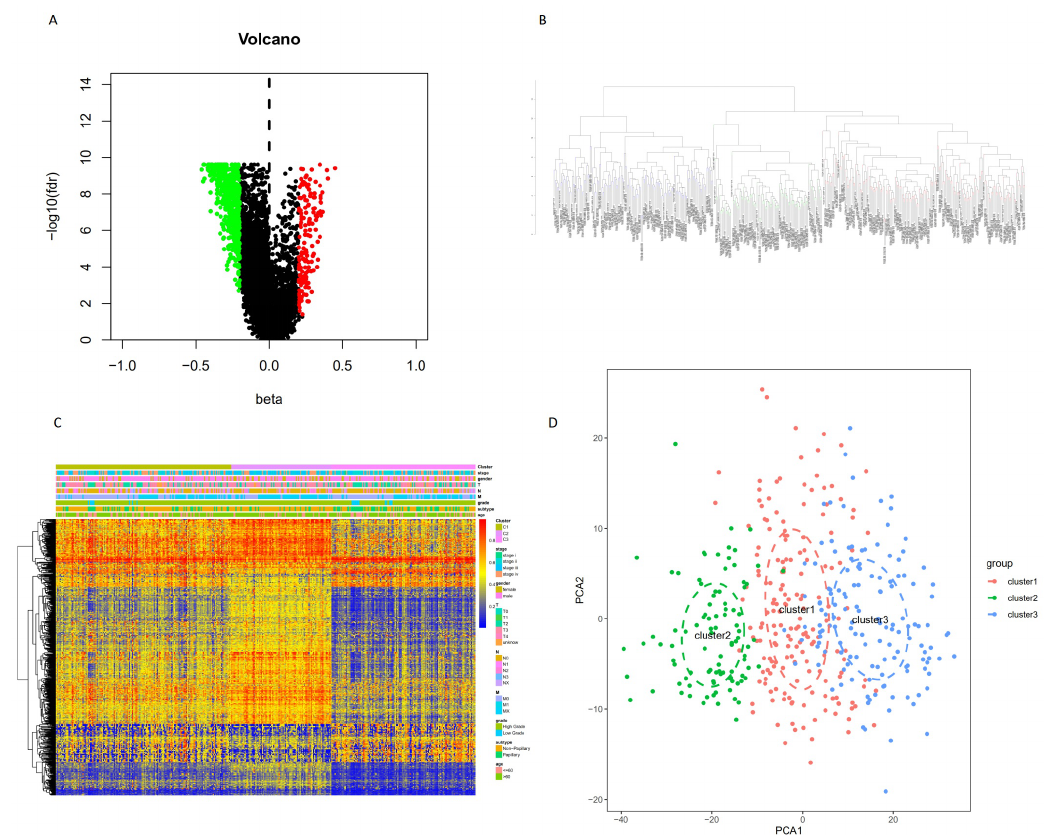
Figure 1. Three subgroups based on di ff erentially methylated sites. ( A ). 715 DMSs between normal samples and bladder cancer samples. ( B ). The consensus clustering of 715 DMSs was divided into three CpG subgroups. ( C ). The heatmap of methylation based on 715 DMSs. ( D ). Principal component analysis (PCA) validated the stability of the